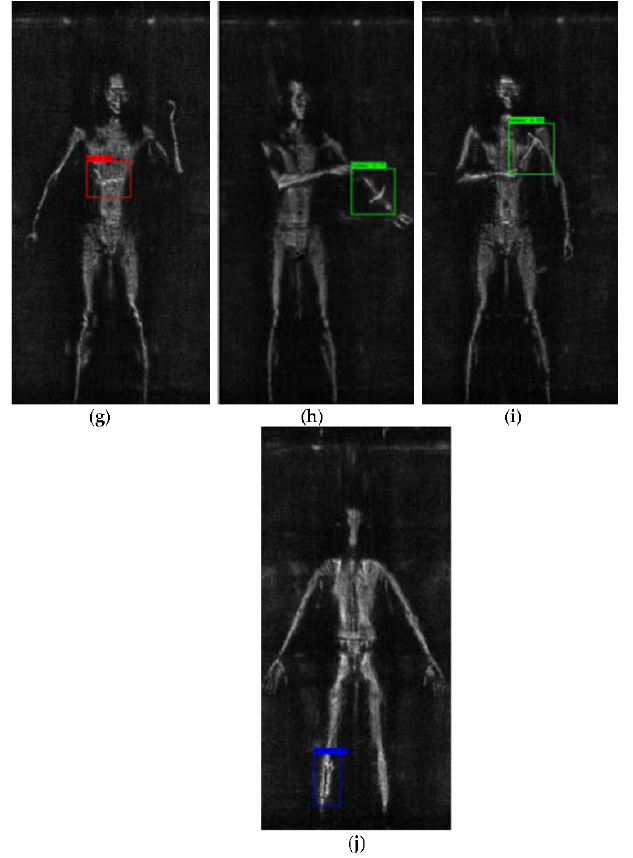
Figure 12. Recognition results of SAR images using MPEN. (a) The targets are placed on the outer thigh. (b) The target is placed on the back. (c) The target is placed on the inner thigh. (d) The target is placed on the outer thigh. (e) The target is placed on the waist. (f) The target is placed on the buttock. (g) The target is placed on the chest. (h) The target is placed on the arm. (i) The target is placed under the armpit. (j) The target is placed on the shank.